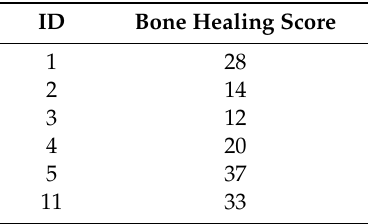
Figure 3. Histology of implantation site: Orange G + Staining of the osseous defect zone. Bone defects were filled with cell-free f-DBM and were followed up for 2 months. The dotted lines show the original defect boundaries; the dotted circles the position of the screws closest to the defect. Table 1. Bone Healing Score as described in Material and Methods; the animal ID was assigned for evaluation and is kept constant throughout the document.